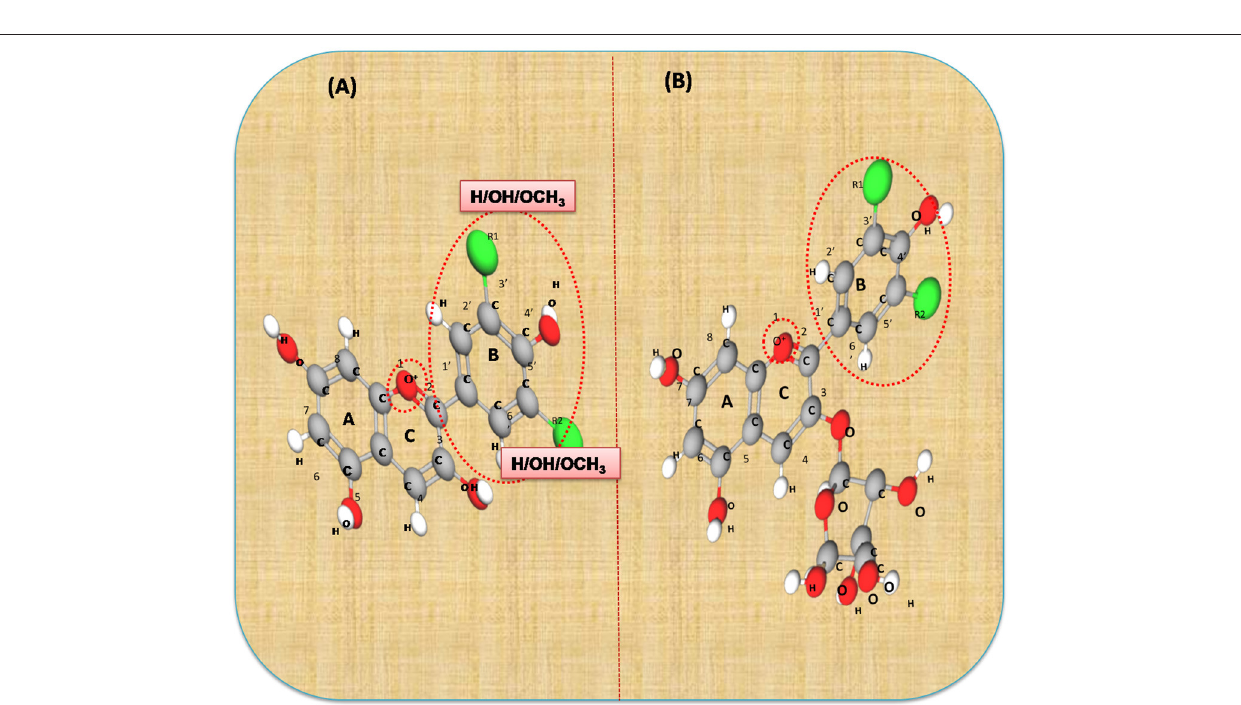
Frontiers in Nutrition |